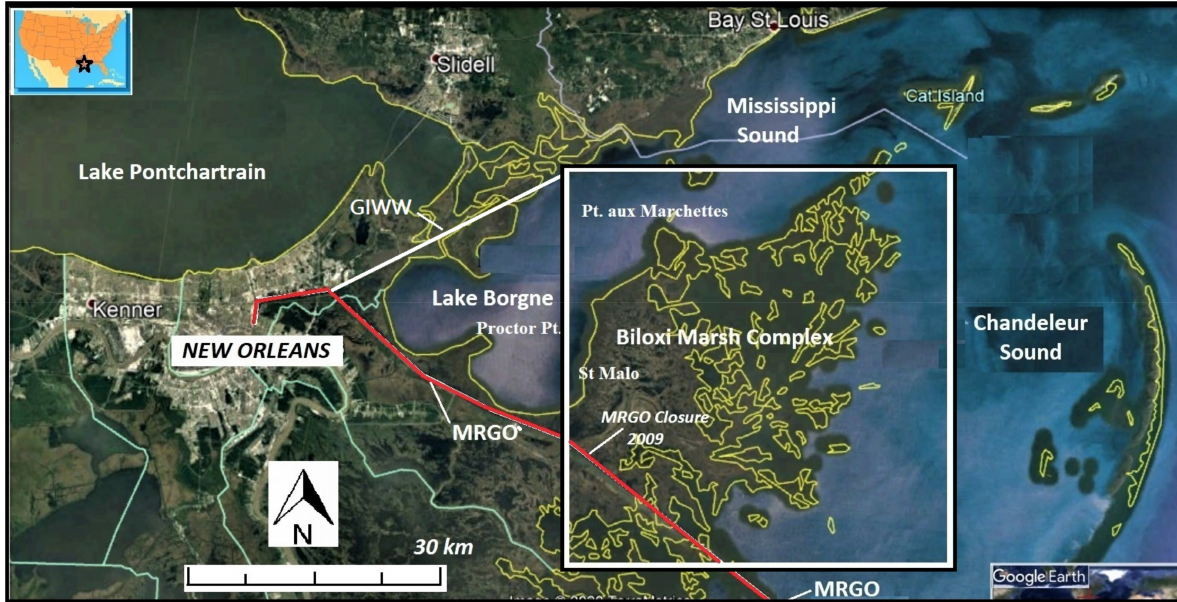
Figure 1. New Orleans and the Biloxi Marsh Study Area showing the Mississippi River-Gulf Outlet in red, and position of the Closure Structure built in 2009. Biloxi Marsh is situated in the triangular “hurricane surge funnel” between the MRGO and Gulf Intracoastal Waterway (GIWW) north of Lake